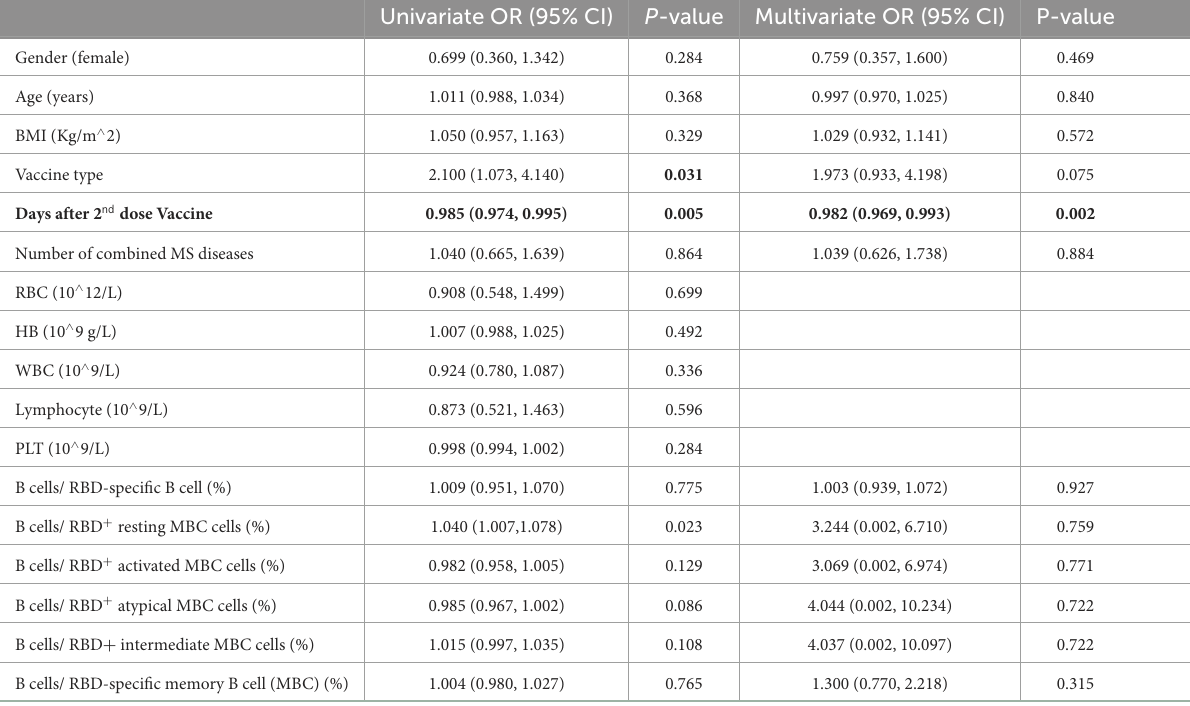
TABLE 3B Univariate and Multivariate analyses for CoV-2 Nab in MS patients. Univariate OR (95% CI) P -value Multivariate OR (95% CI) P-value